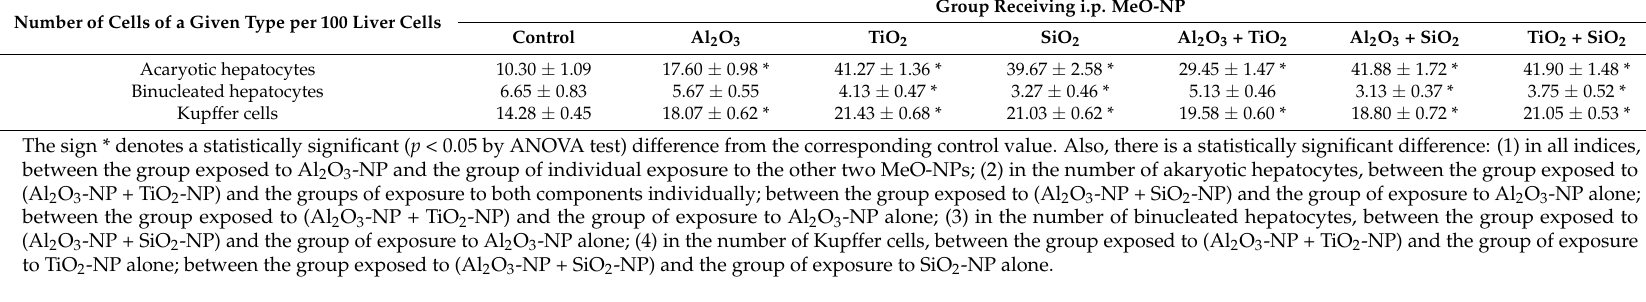
Table 7. Morphometric Indices of Liver and Spleen Status in Rats after Subchronic Exposure to Al 2 O 3 -NP, TiO 2 -NP and SiO 2 -NP in Binary or Ternary Combination (x ±